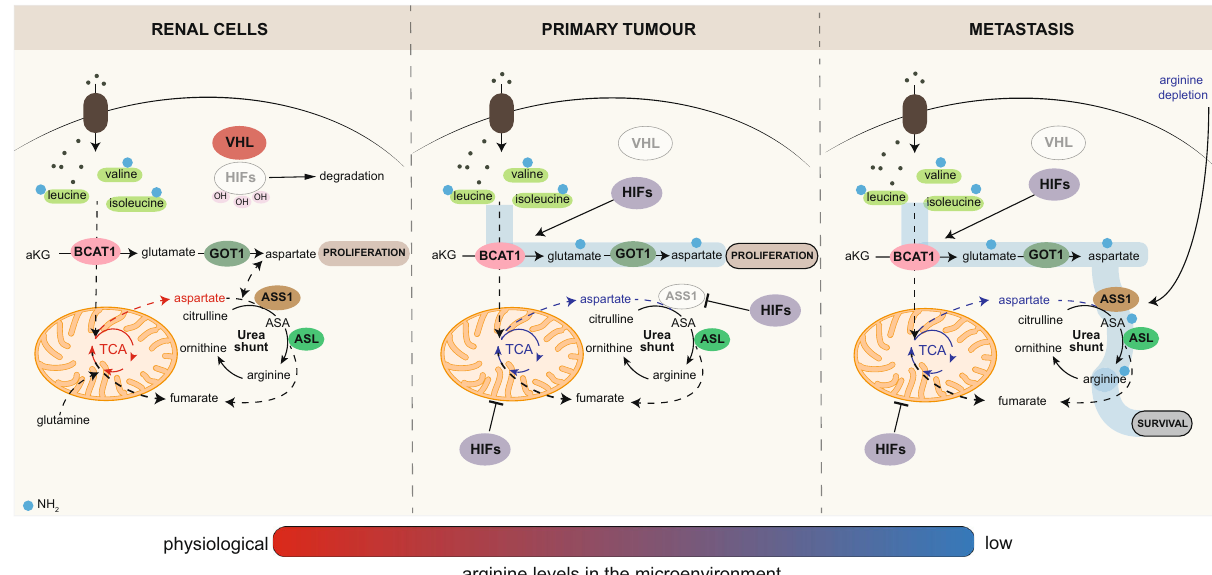
Fig.8|ReprogrammingoftheBCAAaminoacidcatabolismisintertwinedwith the urea cycle enzymes during ccRCC progression. Schematic showing a sum- mary of the metabolic reprogramming in renal cancer cells during progression. Upon VHL loss, renal cancer cells activate a metabolic reprogramming to com- pensate for the aspartate defect that is a consequence of the HIF-dependent mitochondrialdysfunctionpresentinthesecellsthatinvolvescombinedactivation of BCAT1 and GOT1. ASS1 is suppressed, sparing aspartate from consumption